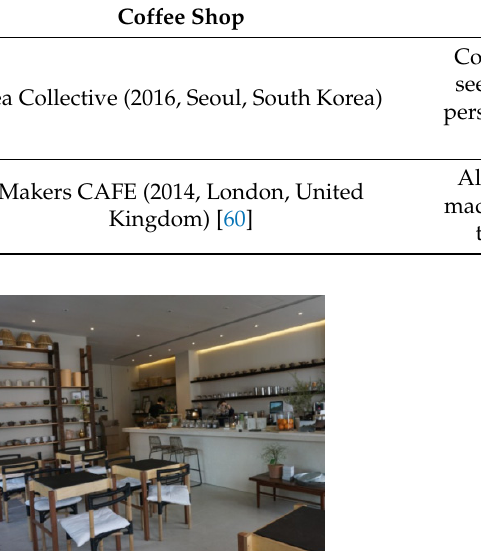
Figure 13. Tea Collective (2016, Seoul, Korea).